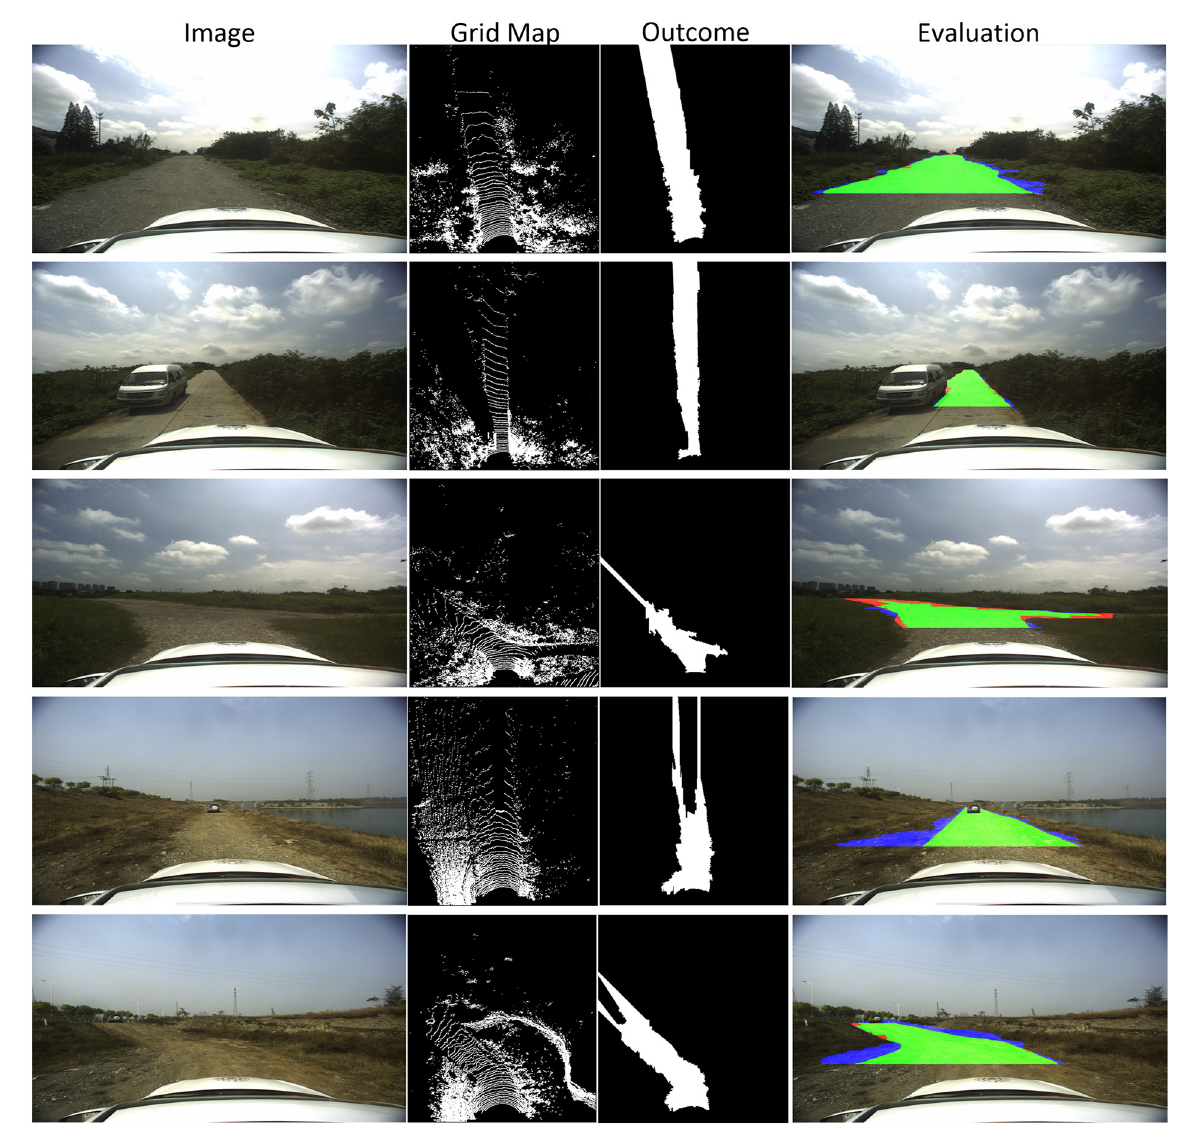
Fig 9. Visual results of RDR on unstructured